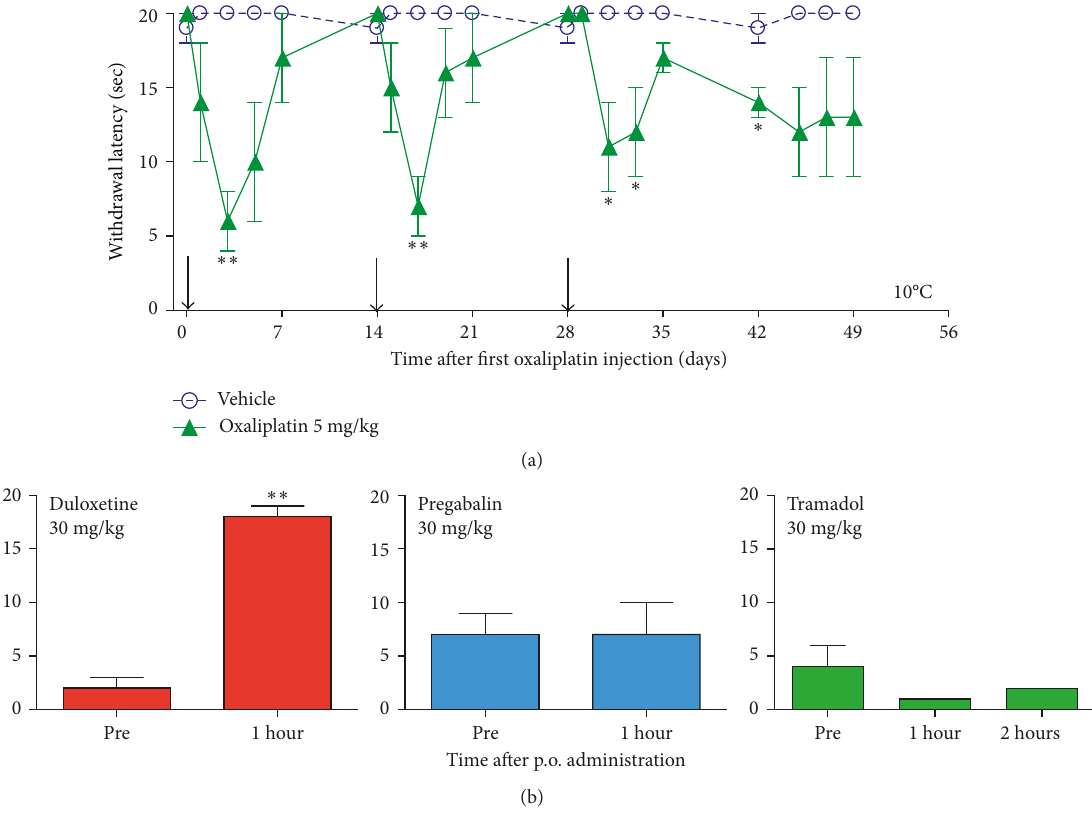
Figure 1: Cold hypersensitivity over time in oxaliplatin-treated macaques. To assess changes to temperature sensitivity, the tail withdrawal test was used [43]. Following habituation to chair restraint, baseline responses of awake cynomolgus macaques to 10 ° C cold water were measured. The distal 10cm of the tail was cleaned and immersed in a cold water bath. The amount of time (in seconds) between tail immersion and withdrawal from the water was recorded and reported as the withdrawal latency. A maximum immersion time of 20 sec. was utilized. Prior to oxaliplatin treatment, the withdrawal latency to cold water was 20 sec. (a) Significant sensitivity to cold (10 ° C) was observed following oxaliplatin treatment. Following baseline assessment, macaques were treated with oxaliplatin (i.v. 5mg/kg, 2hr.